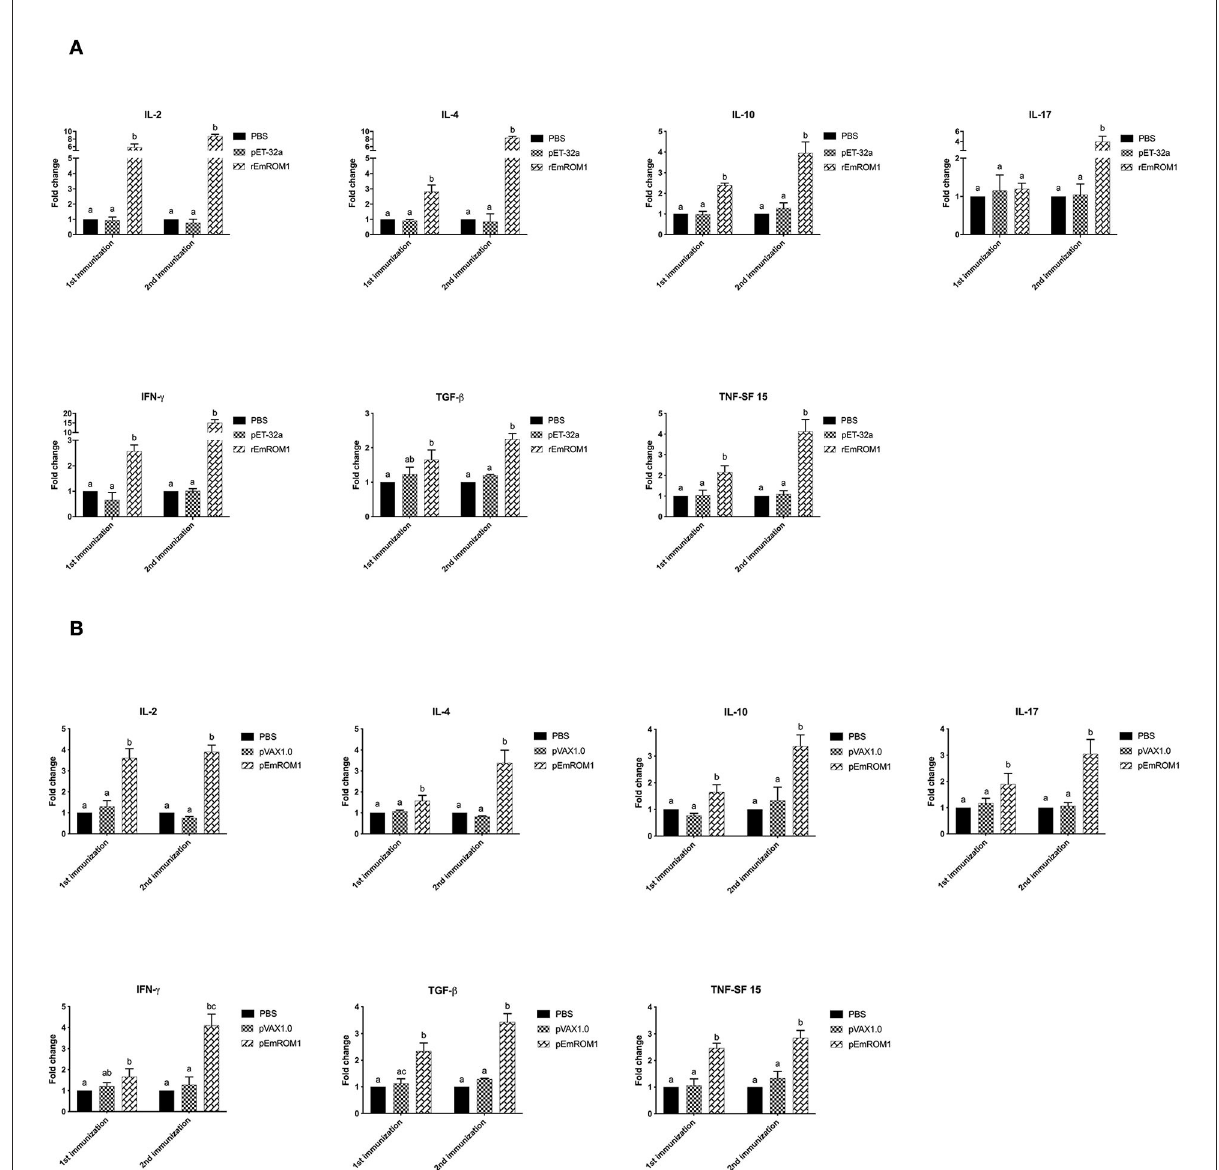
FIGURE5 Transcription level of cytokines in sera from chickens immunized with rEmROM1 or pEmROM1. (A) Transcription level of cytokines in sera from chickens immunized with rEmROM1. (B) Transcription level of cytokines in sera from chickens immunized with pEmROM1. The error bars is regarded as the standard deviation, and five samples in duplicate respectively. Significant difference ( P < 0.05) between groups is marked with different letters. No significant difference ( P > 0.05) between groups is marked with the same